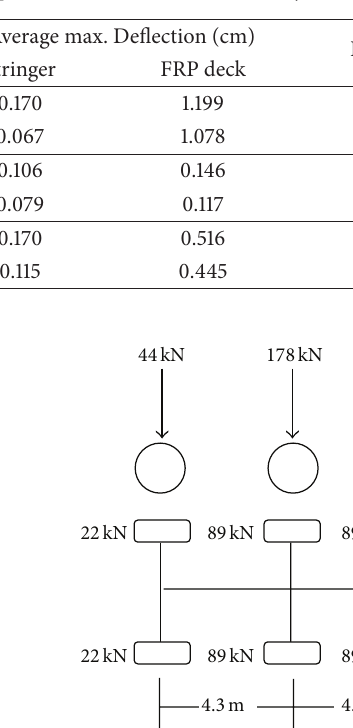
Table 3: Comparison between finite element and experimental results for FRP deck systems.